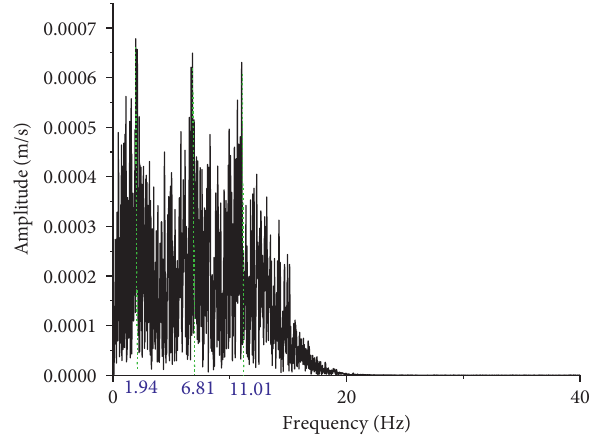
Figure 8: Fourier spectrum of WC seismic wave.